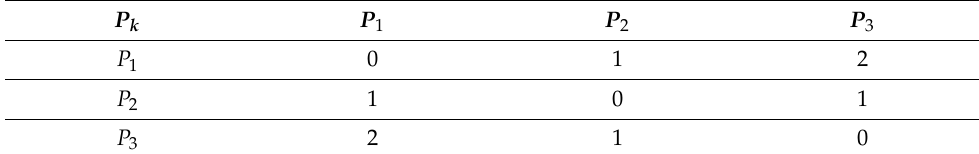
Table 2. Euclidean distances between persons.